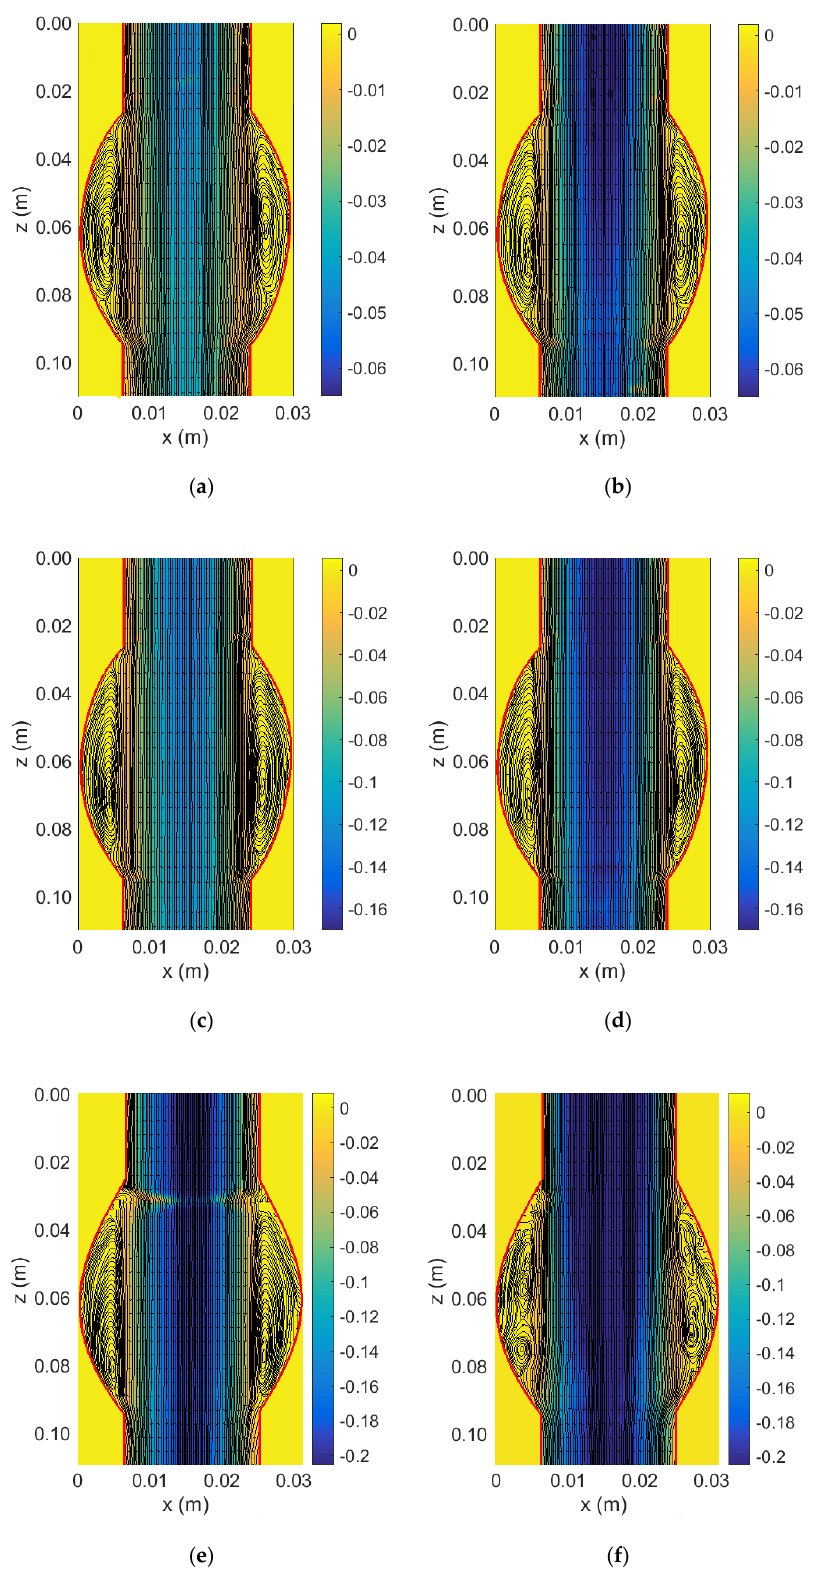
Figure 5. Streamlines and longitudinal velocity (m/s) distribution of the average flow field for the selected Re : ( a ) Re = 410, ( b ) Re = 600, ( c ) Re = 1100, ( d ) Re = 1600, ( e ) Re = 2000, and ( f ) Re = 2650. Data are from the second set of experiments (ID 1’ to 6’, Table 1).